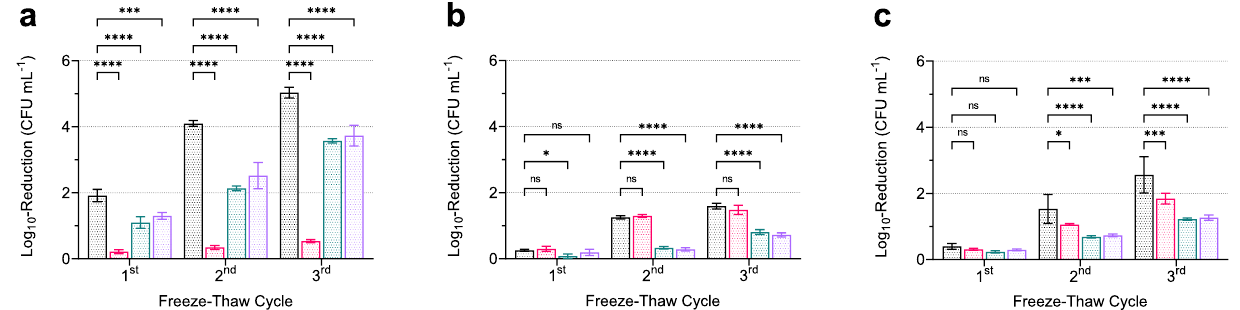
Figure 4. Logarithmic reduction of viable cell counts after freeze-thaw stress test. Listeria monocytogenes strains DSM 20600 T ( a ), FFH ( b ), and FFL 1 ( c ) grown at 6 °C in tryptic soy broth-yeast extract medium (TSB-YE) without supplementation (black), with 0.1% (wt/vol) polysorbate 60 (red), with 0.1% (wt/vol) polysorbate 80 (green), and with 0.1% (wt/vol) salmon lipid extract (indigo) after one, two and three freeze-thaw cycles (each 24 h) relative to the initial cell count. Values are means ± standard deviation ( n = 3). Asterisks represent p values (* p < 0.001, ** p < 0.0001, *** p < 0.00001, **** p < 0.000001) compared to cultures in TSB-YE without